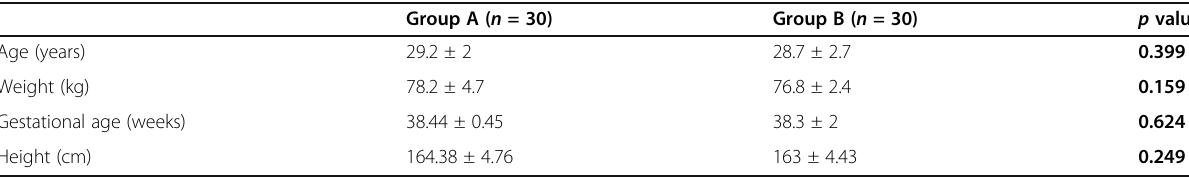
Table 1 Demographic data